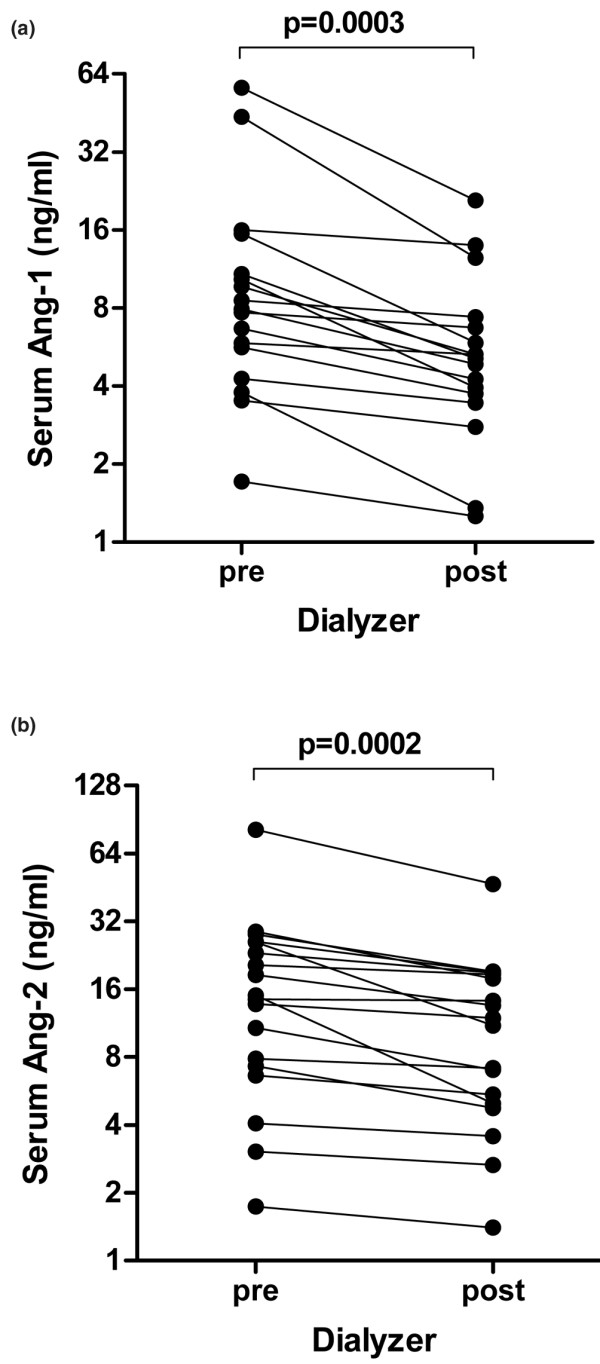
Predialyzer and postdialyzer angiopoietin-1 and angiopoietin-2 concentrations. Aligned dots indicate individual predialyzer and postdialyzer angiopoietin-1 (Ang-1) and angiopoietin-2 (Ang-2) concentrations. (a) Median Ang-1 concentrations decreased an average 36.2% from 7.9 ng/ml (1.7 to 56.6 ng/ml) (predialyzer sample) to 5.1 ng/ml (1.3 to 20.8 ng/ml) (postdialyzer sample) (P = 0.0003). (b) Median Ang-2 concentration decreased by 23.1% from 14.7 ng/ml (1.7 to 81.5 ng/ml) (predialyzer sample) to 11.5 ng/ml (1.4 to 46.9 ng/ml) (postdialyzer sample) (P = 0.0002).